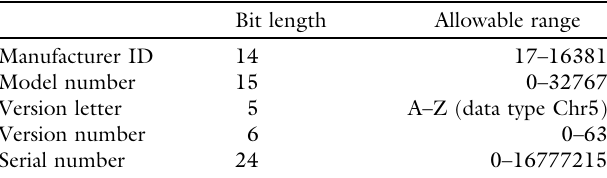
Table 1. Basic TEDS content.